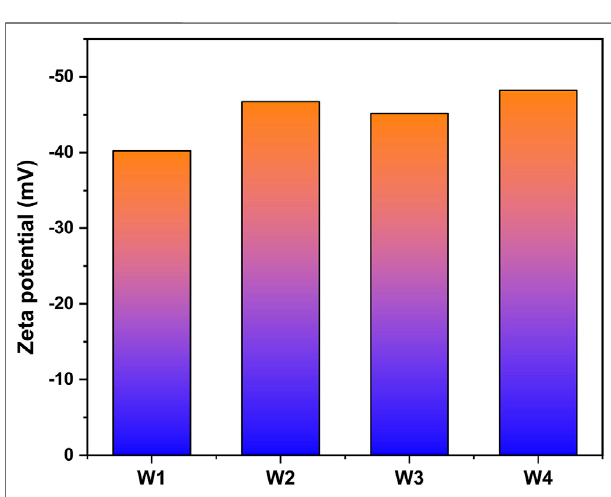
FIGURE 4 | Zeta potential of P-SSC